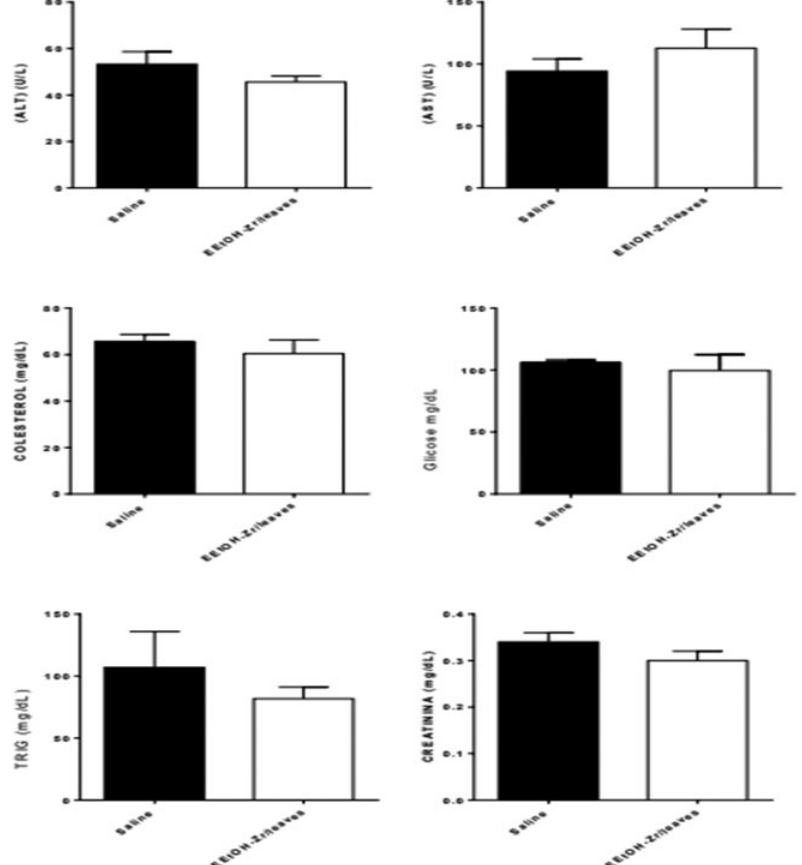
FIGURE 5 - Biochemistry analysis of the plasma of male rats treated with saline and EEtOH-Zr/leaves, orally, with a single dose of 2,000 mg/kg, in a volume of 10 mL/kg. Values were expressed as mean ± s.e.m. control; (■) and (□) EEtOH-Zr (14